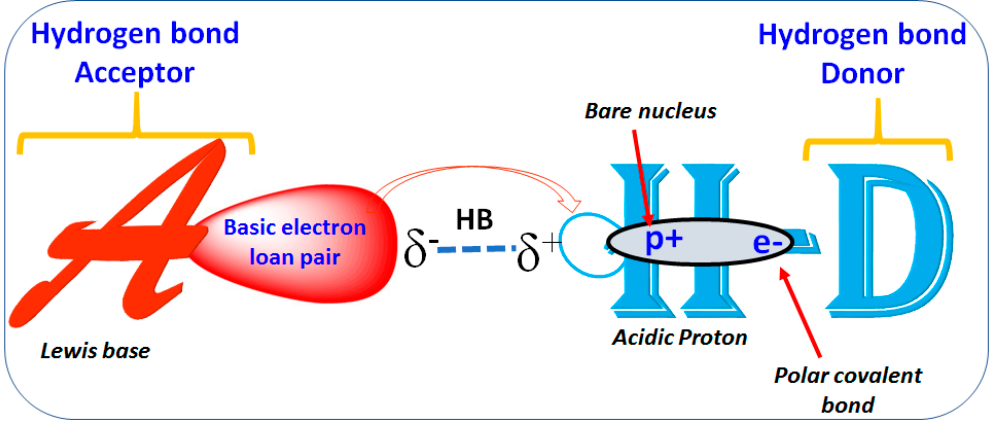
Figure 2. The pictorial illustration of hydrogen bond interaction, where HB acceptor/donor can be F, O, N, or S atom in the molecule. Polarization of electron and exposure of positive proton on either side is shown schematically. The figure and the associated text were adapted from